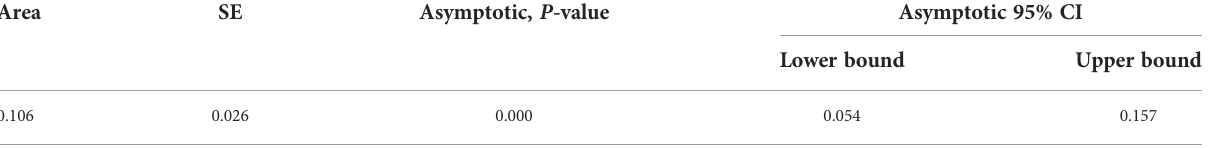
TABLE 7 Area under the receiver operating characteristic